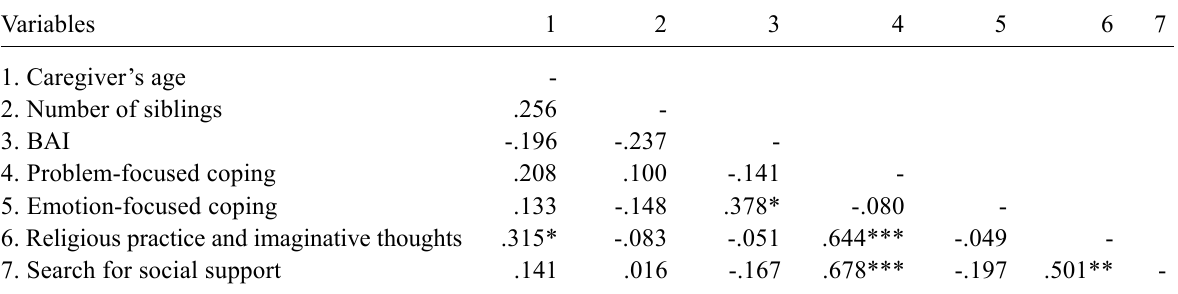
Anxiety and Coping Measures